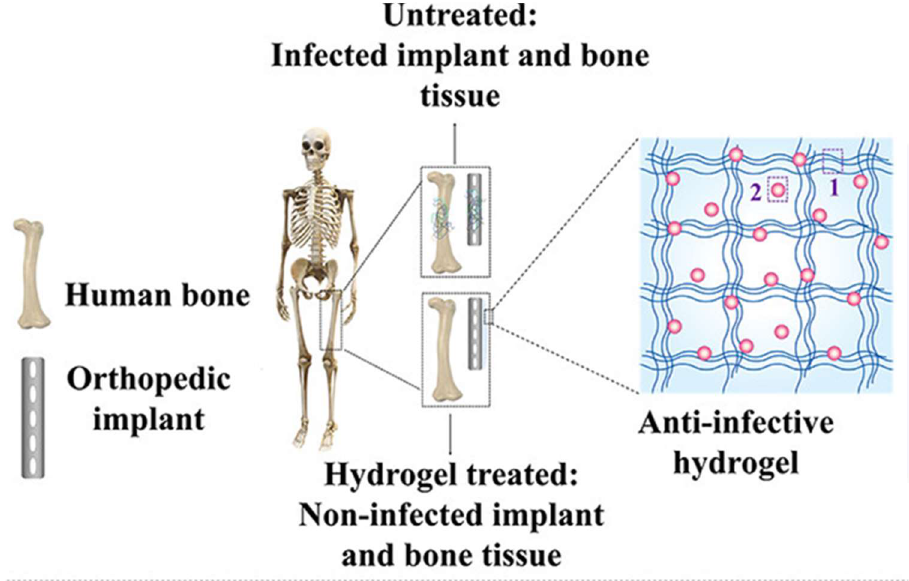
Figure 4. Schematic of hydrogel-treated orthopedic implants preventing infection. 1 represents the hydrogel polymer and 2 representes the antibiotic material within the hydrogel. Reprinted with permission from Ref. [108] Copyright 2021 American Chemical Society.